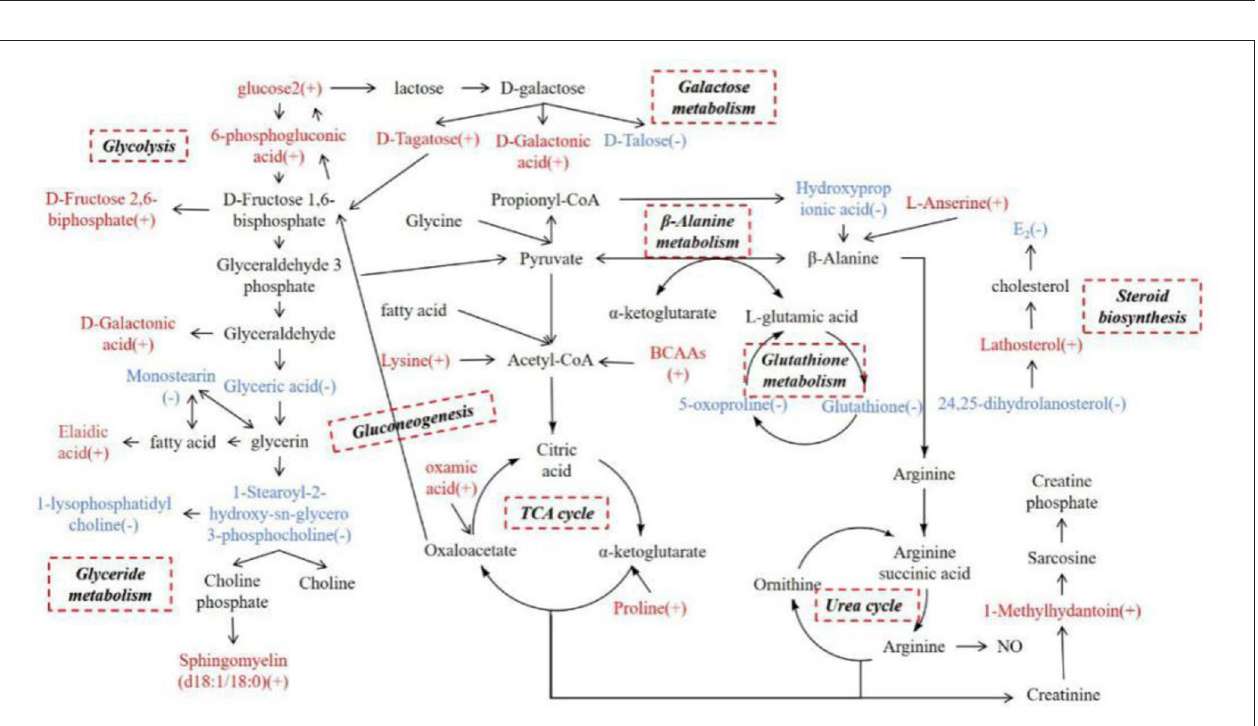
FIGURE 5 | Hierarchical clustering analysis of 30 metabolites in serum from cows in estrus (the E group) and from cows with inactive ovaries (the IO group). The heat map shows the qualified metabolites using a red–black–green scheme. Red indicates that the metabolite is increased compared to the mean of the IO group, and green indicates that it is reduced. Each column represents a sample, and each row signifies an individual metabolite.